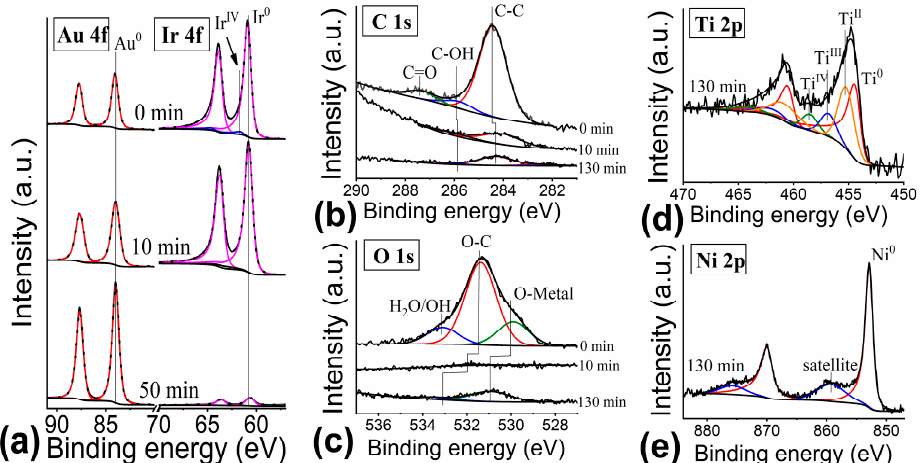
Figure 11. XPS spectra of Ir/Au/TiNi sample at different Ar + etching times: ( a ) Au 4f and Ir 4f; ( b ) C 1s; ( c ) O 1s; ( d ) Ti 2p; and ( e ) Ni 2p.